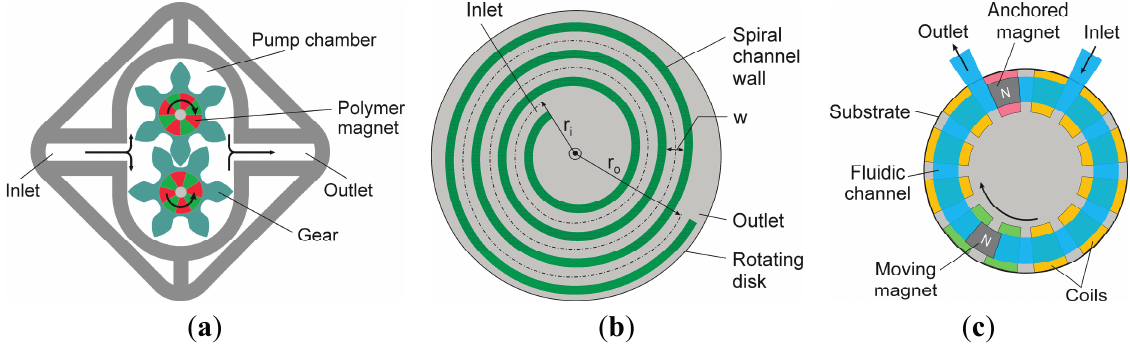
Figure 7. Schematics of micro pumps: ( a ) micro gear pump (according to [33]); ( b ) spiral channel viscous micropump (according to [34]); and ( c ) synchronous electromagnetic micropump (according to [36]).